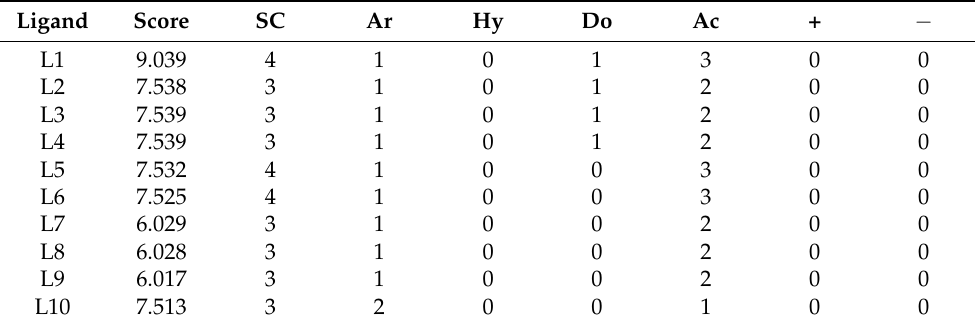
Table 2. Results of the superposition with ezetimibe A. SC: spatial characteristics, Ar: aromatic (aromatic rings), Hy: hydrophobic (prominent hydrophobic groups), Do: donors (hydrogen bond donors), Ac: acceptors (hydrogen bond acceptors), +: positive (cationic centers), − : negative (anionic centers) [37].